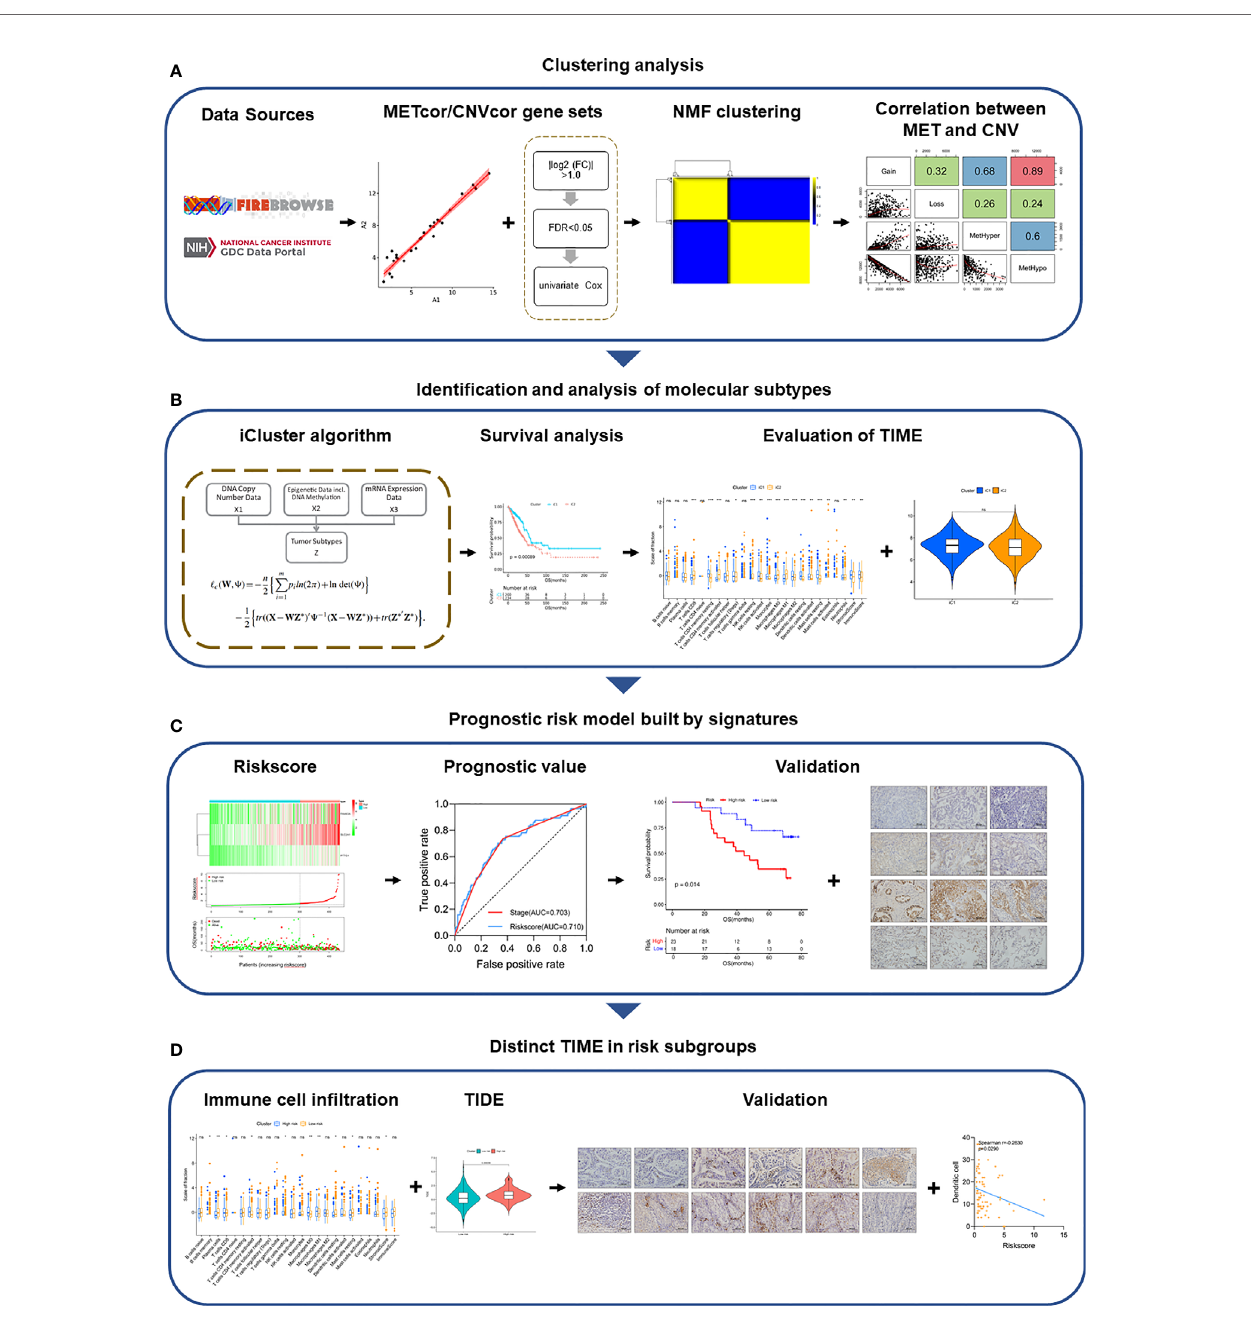
FIGURE 6 | Overview of the study design. (A) Clustering analysis of METcor/CNVcor gene sets by NMF. (B) Identi fi cation and analysis of molecular subtypes. (C) Signatures of molecular subtypes built the prognostic risk model, which was validated in multiple cohorts. (D) Distinct TIME of risk subgroups was validated by